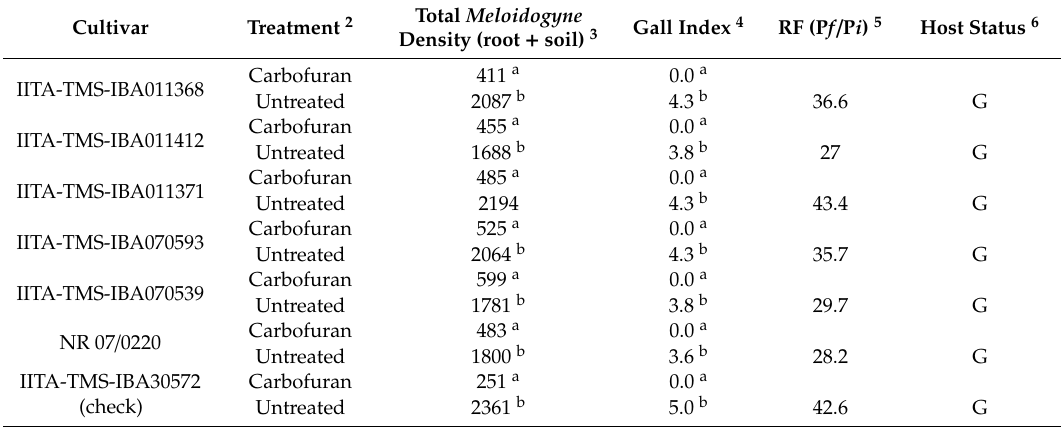
Table 2. Root galling damage and host suitability of six biofortified cassava cultivars due to Meloidogyne spp, 12 months after planting in field trials in Nigeria 1